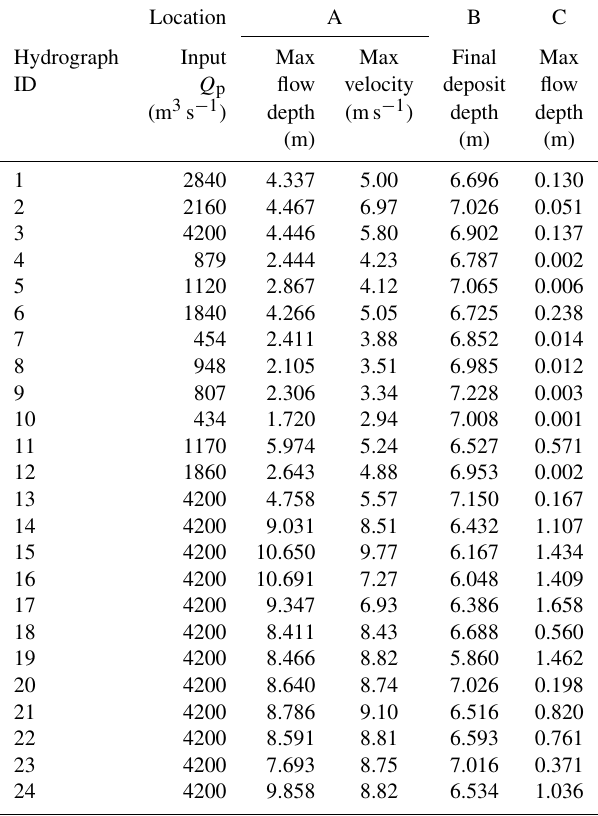
Table A2. Summary of outputs for the Currie D simulations using f = 0 . 13, ξ = 50ms − 2